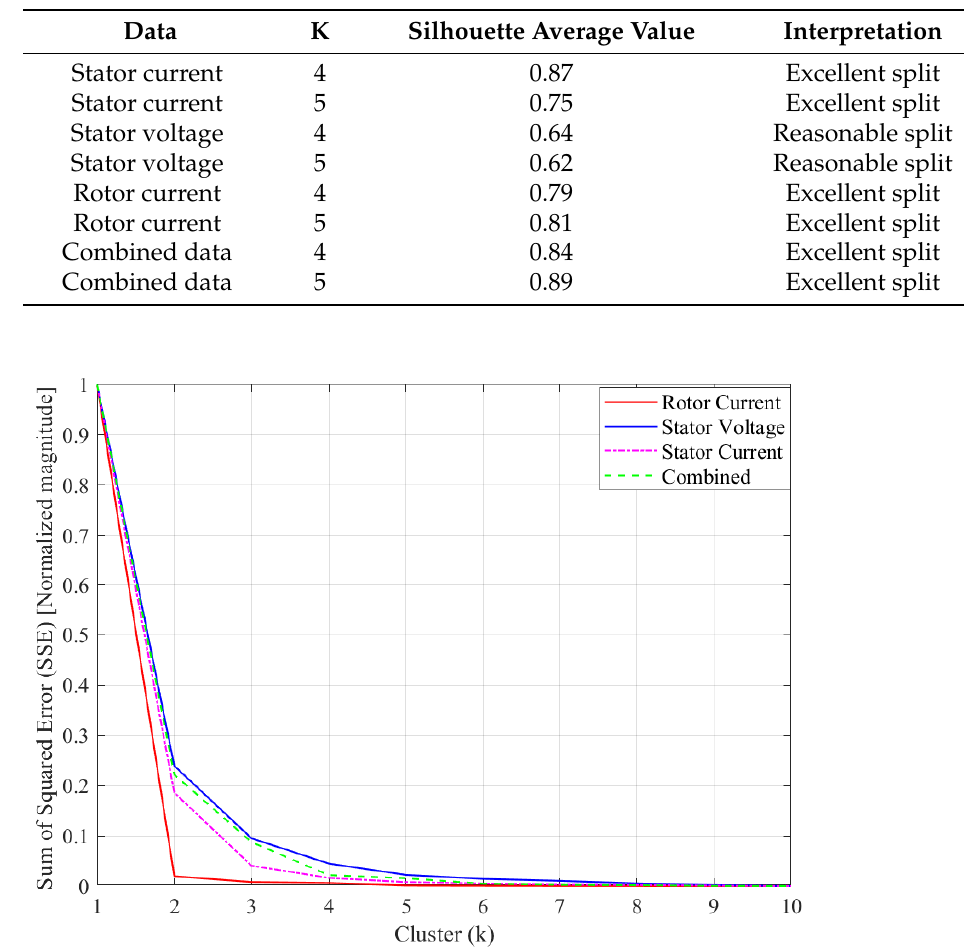
Table 4. Summary of Silhouette average results.